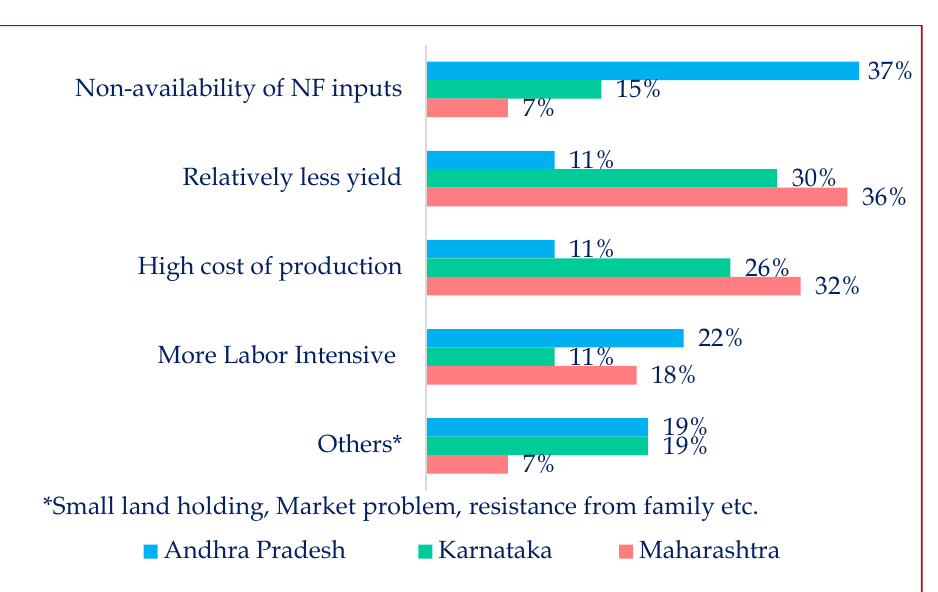
Figure 7. Reasons of non-NF farmers for not adopting NF (in % of surveyed non-NF farmers). However, 60% of NF farmers also do not have indigenous cows, rather they buy all inputs from the village’s nutrient shops, while a few collect them from fellow farmers. The expectation of poor crop yield was also one of the reasons for the non-adoption of NF by non-adopted farmers (m ore than 30% in Karnataka and Maharashtra). NF was perceived to be more labor intensive and regular monitoring is required from the part of farmers.